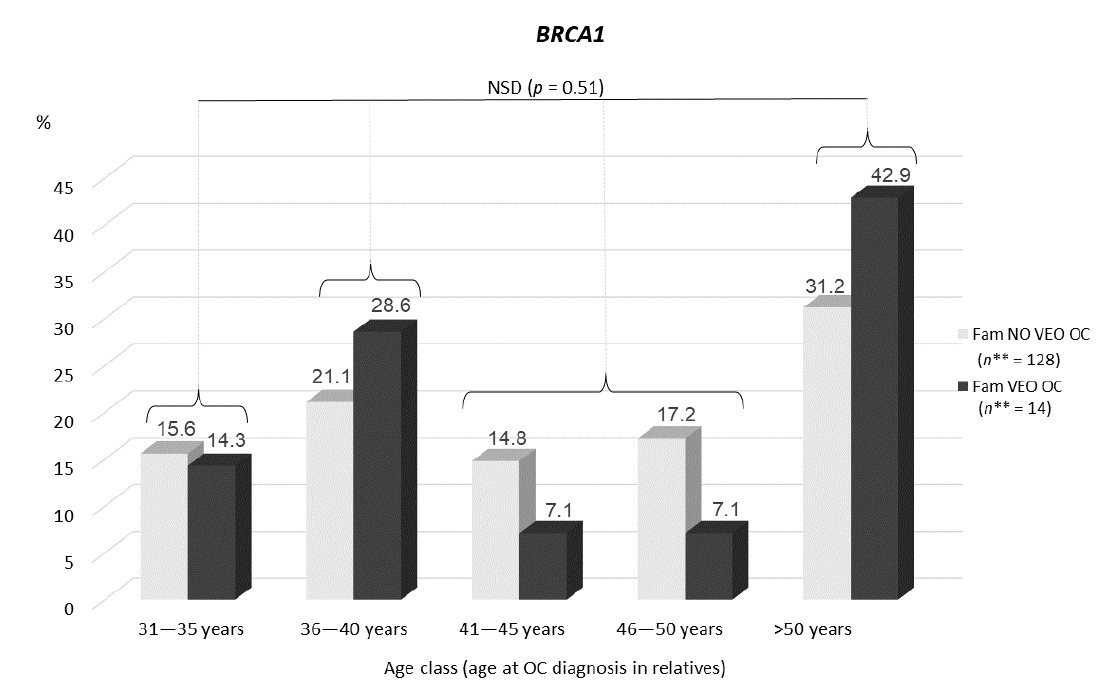
Figure 4. Distribution of ages at BC and OC diagnosis of relatives; comparison of families with VEO cancer and no VEO cancer. Fam. VEO-BC: families including at least one VEO-BC case; Fam. VEO-OC: families with at least one VEO-OC case; Fam. NO VEO-BC: families with no VEO-BC case; Fam. NO VEO-OC: families with no VEO-OC case. n **: Number of women with available data for age at BC diagnosis. Of note: for women with multiple BC diagnoses, the youngest age at diagnosis was considered. a : among BRCA1m carrier women. b : among BRCA2m carrier women. NSD: non-significant difference.31–35.